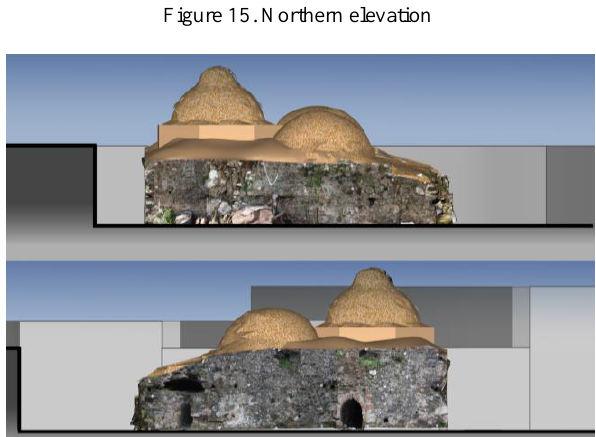
Figure 16. Above: Southern Elevation; Below: Northern